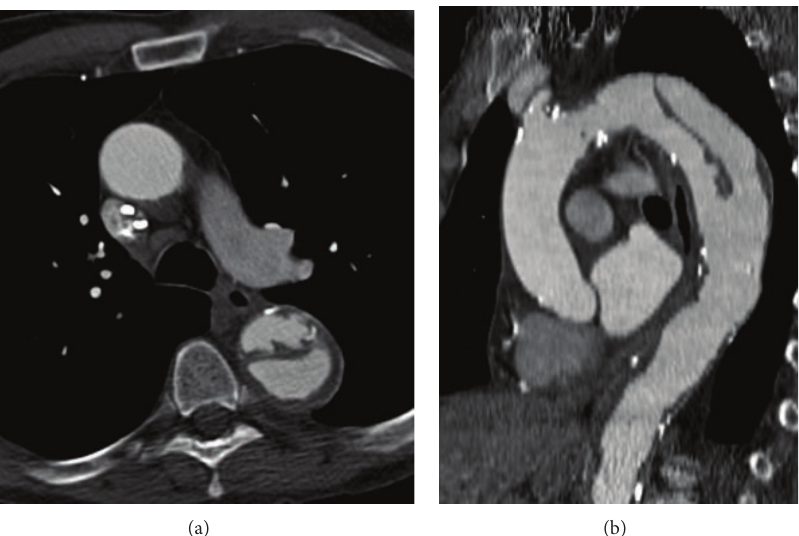
Figure 13: Type B dissection—(a) axial CT scan image in a 65-year-old male shows a dissection flap seen only in the descending thoracic aorta but not in the ascending aorta. (b) Sagittal reconstructed post contrast CT image in the same patient shows a dissection flap that involves the arch and proximal descending thoracic aorta, consistent with Type B dissection. The true lumen is anterior and medial, where the false lumen is posterior to